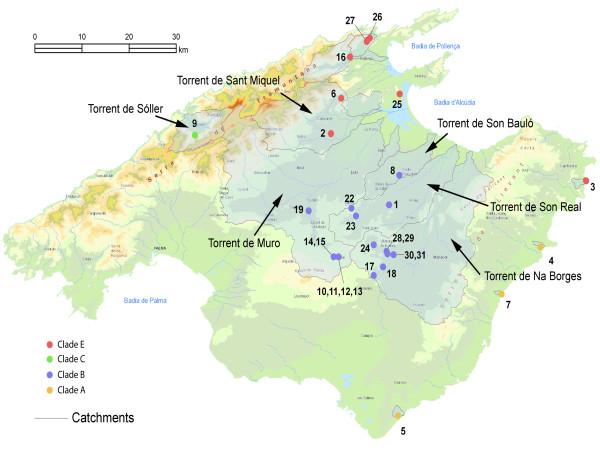
Major Mallorcan clades and hydrographic catchments. Map of Mallorca showing the correspondence between hydrographic catchments and distribution of major clades recognized based on mtDNA phylogenetic information. The map of Menorcan hydrographic catchments is not shown as the two sampling sites are from anchialine caves.